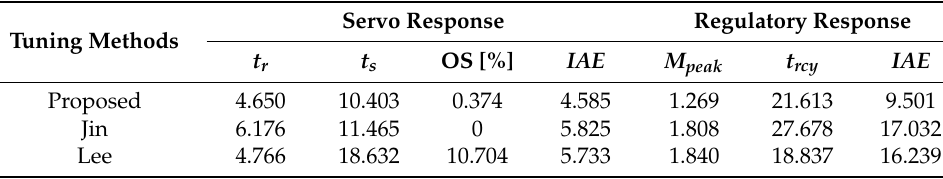
Figure 6. Unit step responses for nominal process 𝑃 2 . Table 5. Performance comparisons for nominal process P 2 .